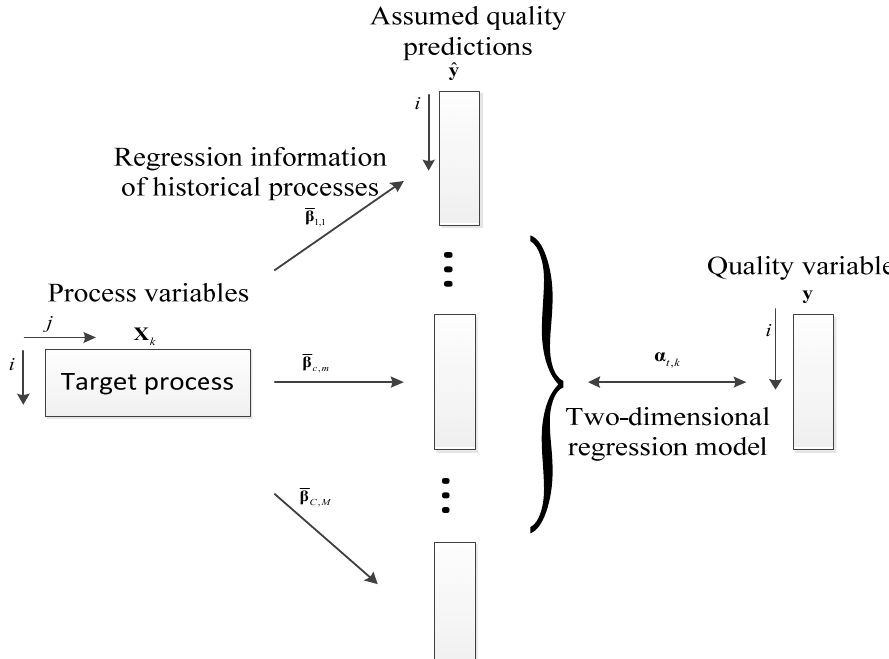
Figure 2. Illustration of two-dimensional, two-layer regression modeling.